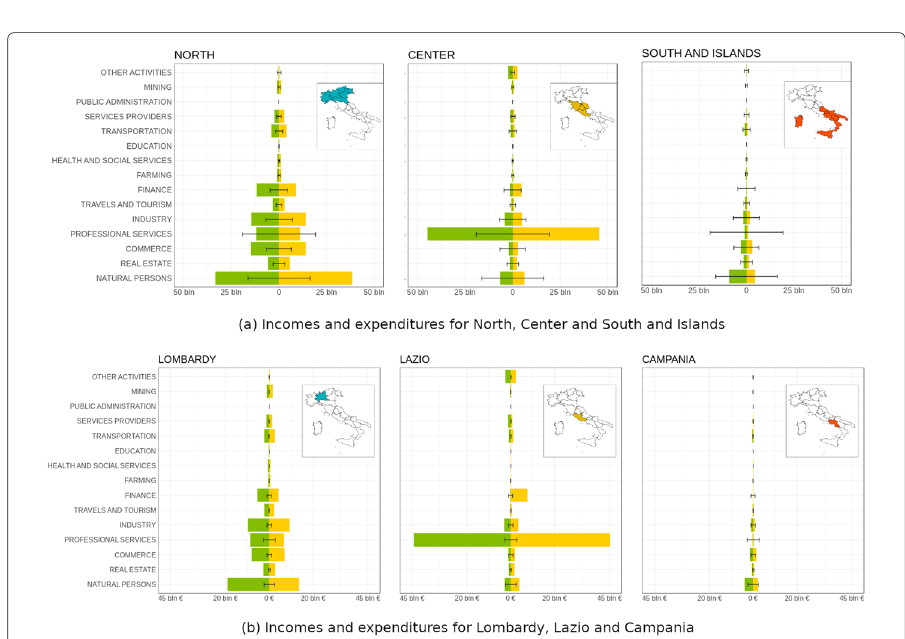
Fig. 18 Incomes and expenditures distributions divided by NACE codes and grouped by geographical area (top) and sample regions (bottom). Incoming and outgoing amounts are coloured are coloured respectively in green and in yellow. Black ticks show the averages for the given business sector. Northern regions outperform in the majority of sectors, especially in industry, commerce, and finance. Regions in the Centre are particularly focused on professional services. Conversely, the South and Islands under perform in every NACE sectors. Also natural persons’ behaviour is quite unequal, confirming the trend. Switching to regions, Lombardy is confirmed as the leading region in all the sectors, but professional services that are mainly centred in Lazio. Although Campania is the most active in the South, it still performs under the regional average in all sectors, but commerce. It is also striking that Campania receives more money from the other regions than what it